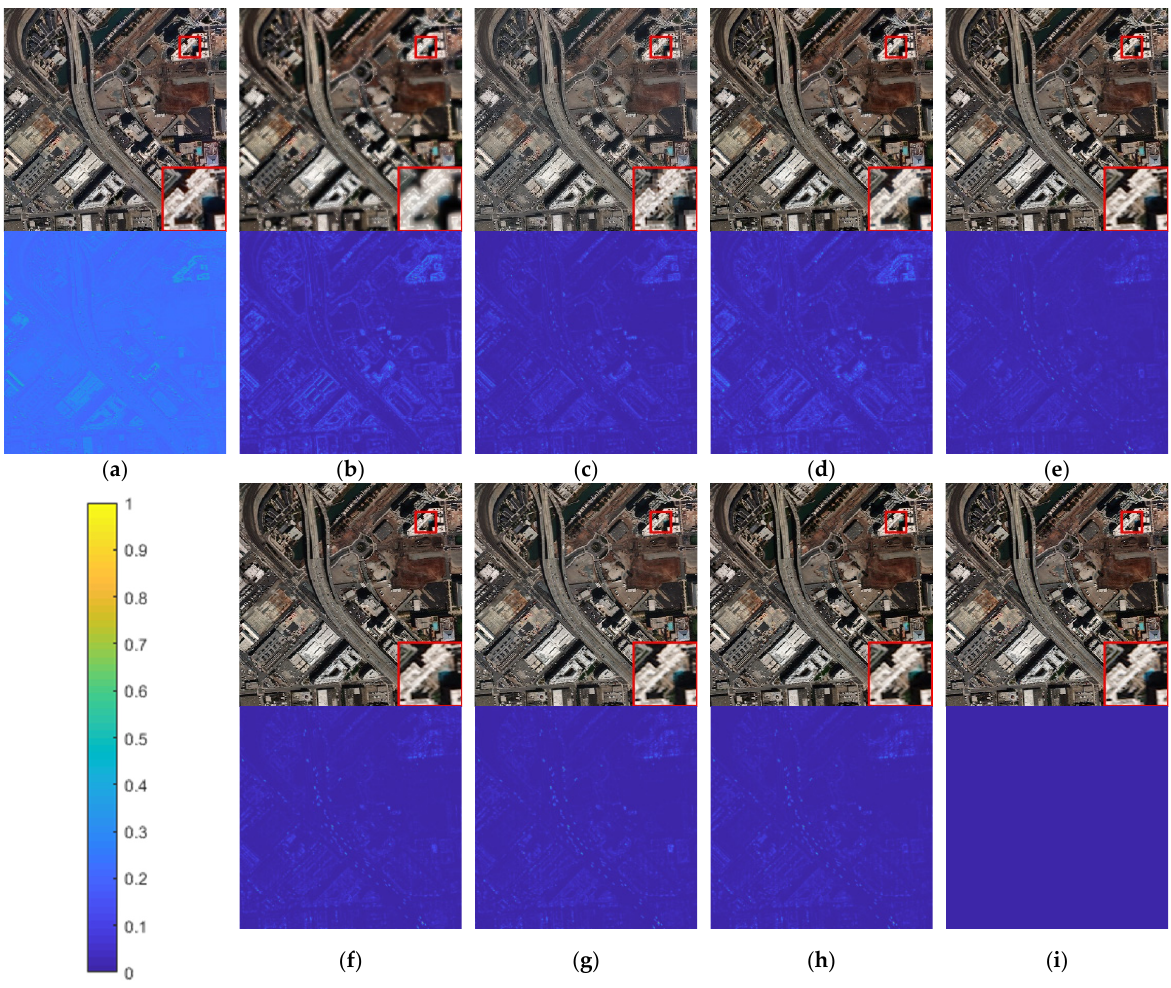
Figure 10. Simulation experiment results using the WorldView-2 dataset. ( a ) IHS, ( b ) HPF, ( c ) PRACS, ( d ) Wavelet, ( e ) PNN, ( f ) FusionNet, ( g ) Pansformers, ( h ) LNFIN, ( i )